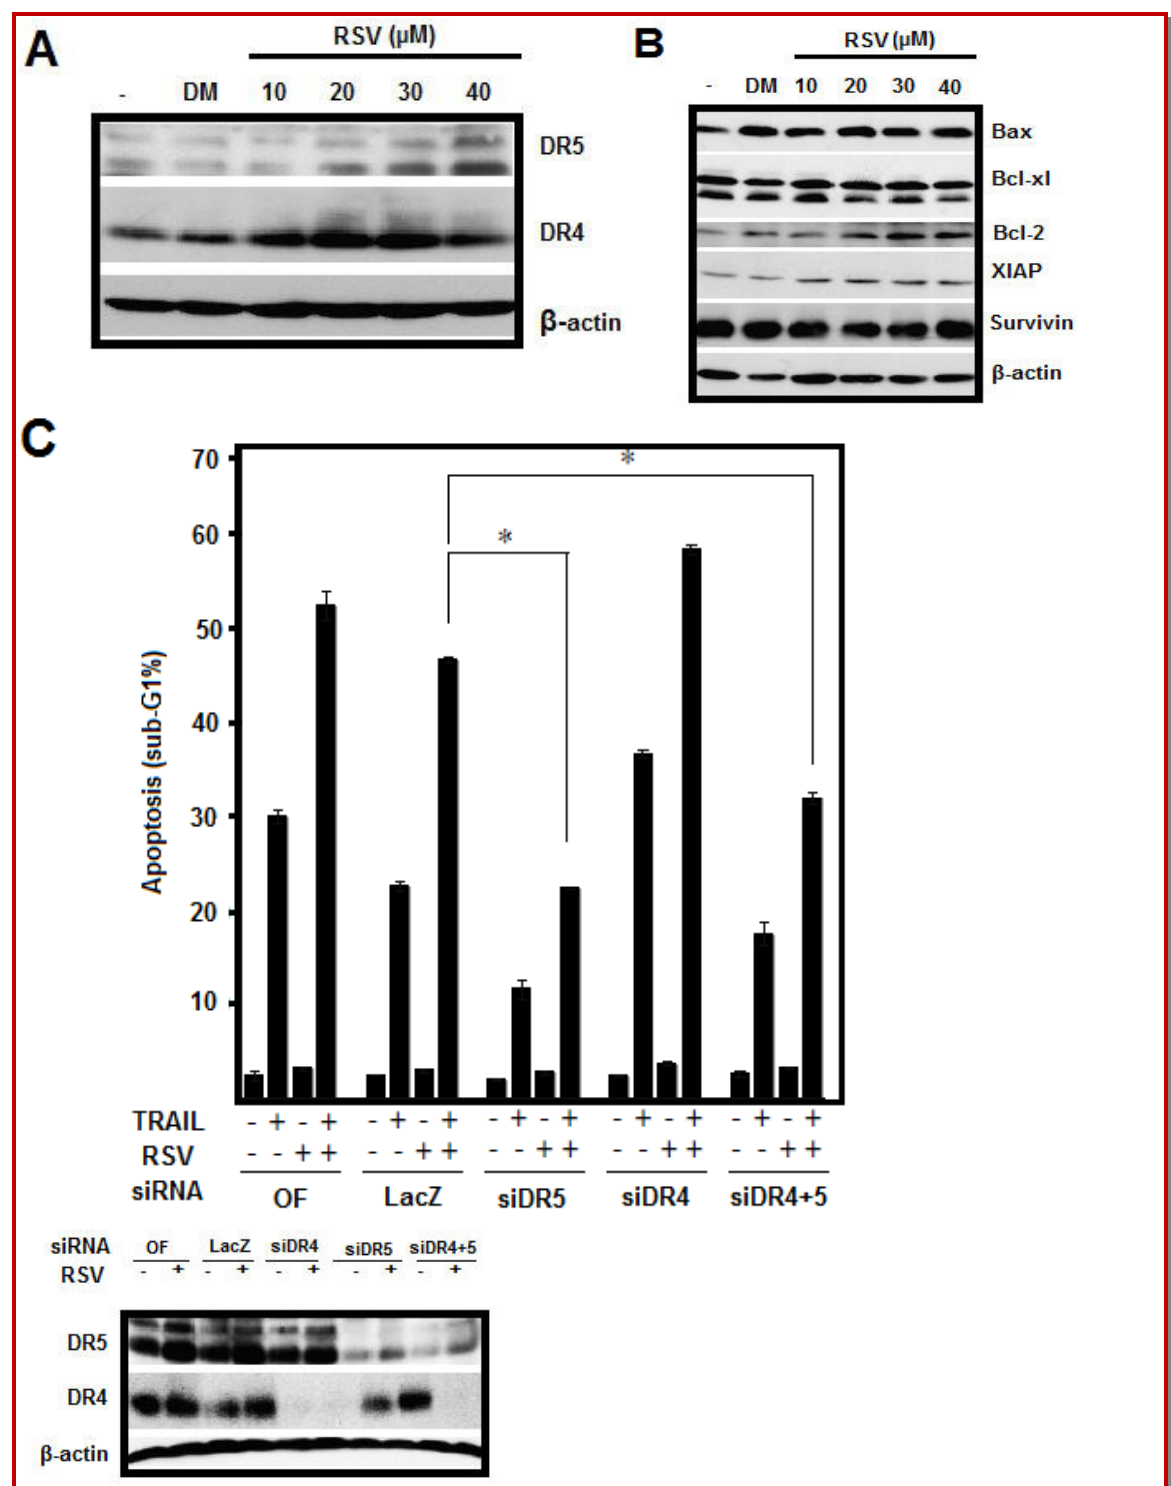
Figure 4: (A) Western blotting of DR5 and DR4. Caco cells were treated with the indicated concentrations of resveratrol for 24 hours. β -actin is a loading control. (B) Western blotting of XIAP, survivin and bcl-2 family proteins. — , no treatment; DM, solvent DMSO treatment. (C) Caco cells were transfected with DR5, DR4 or control LacZ siRNA (40 nM). Twenty-four hours after trans- fection, cells were treated with 20 ng/mL of TRAIL and/or 40 µM resveratrol for 24 hours. The values shown are means (n = 3); bars ± SD;